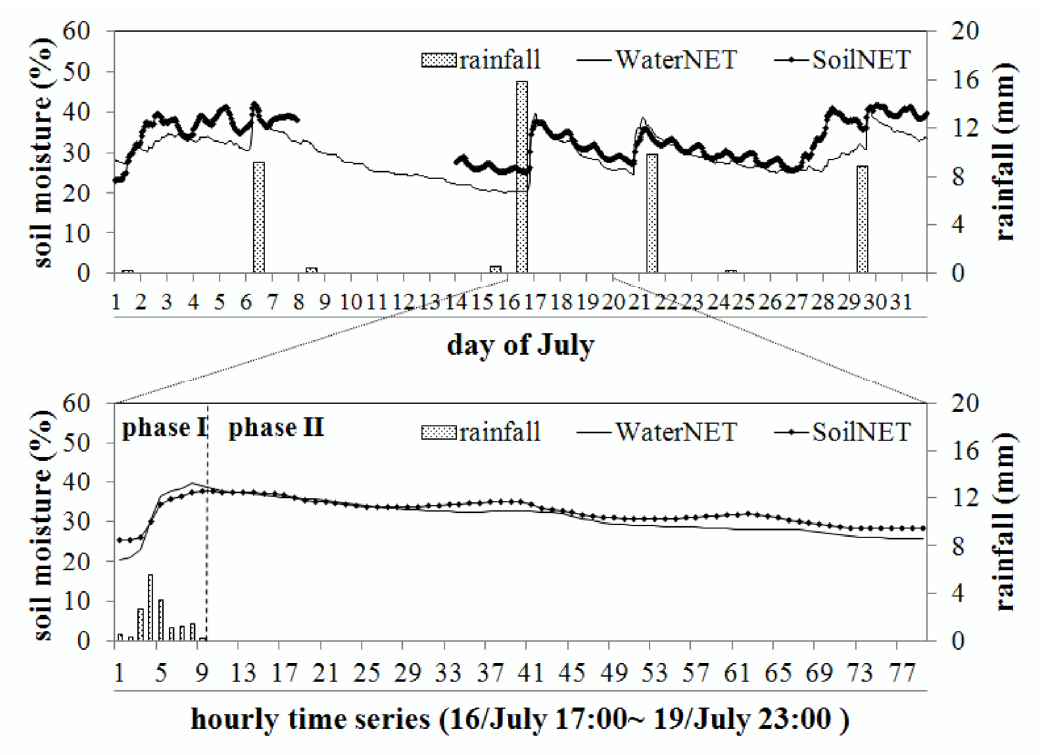
Figure 2. Hourly mean soil moisture and rainfall for the WaterNET and SoilNET datasets during the observation